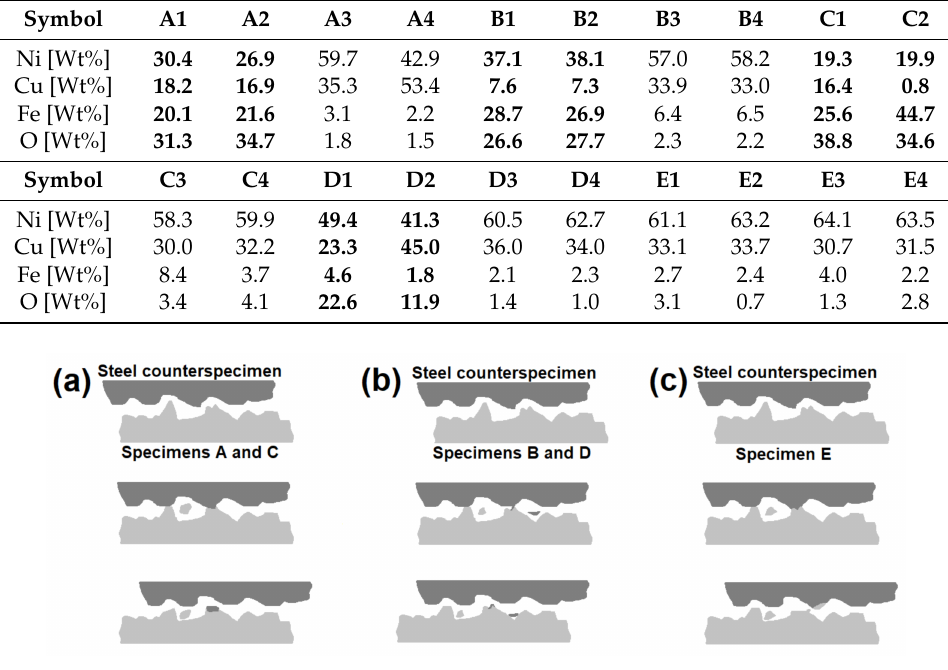
Figure 10. Schemes of wear mechanisms on di ff erent specimens: ( a ) Specimens A and C: serious abrasive wear of the specimen and adhesive wear of the counterspecimen, ( b ) Specimens B and D: minor abrasive wear of the specimen and adhesive wear of the counterspecimen, ( c ) Specimen E: serious abrasive and adhesive wear of the specimen, with plastic